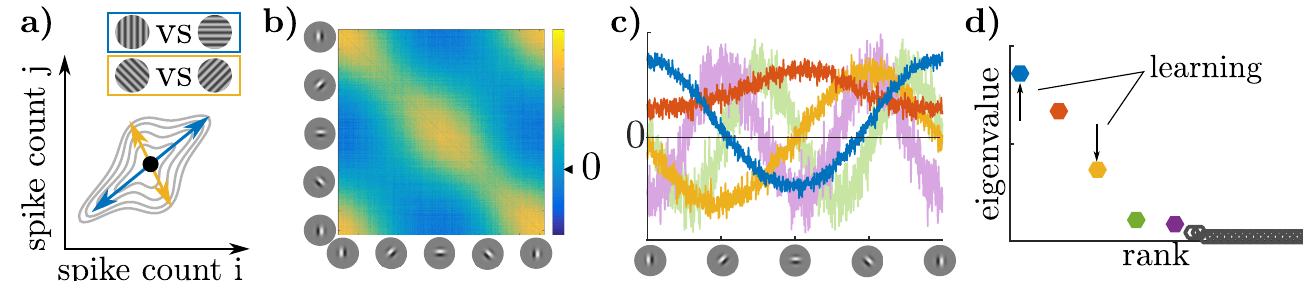
Fig 6. Inferring the structure of internal beliefs about a task. a) Trial-to-trial fluctuations in the posterior beliefs about x imply trial-to-trial variability in the mean responses representing that posterior. Each such ‘belief’ yields increased correlations in a different direction in r . The model in (b-d) has uncertainty in each trial about whether the current task is a vertical-horizontal orientation discrimination or an oblique discrimination. b) Correlation structure of simulated sensory responses during discrimination task. Neurons are sorted by their preferred orientation (based on [34]). c) Eigenvectors of correlation matrix (principal components) plotted as a function of neurons’ preferred orientation. The blue vector corresponds to fluctuations in the belief that either a vertical or horizontal grating is present, and the yellow corresponds to fluctuations in the belief that an obliquely-oriented grating is present. See Methods for other colors. d) Corresponding eigenvalues color-coded as in (c). Our results on variable beliefs ( π ) predict an increase over learning in the eigenvalue corresponding to fluctuations in belief for the correct task, while our results on filtering noise predict a relative increase in the task-relevant eigenvalue compared with variance in other tasks’ directions (e.g. if both blue and yellow decrease, but yellow more